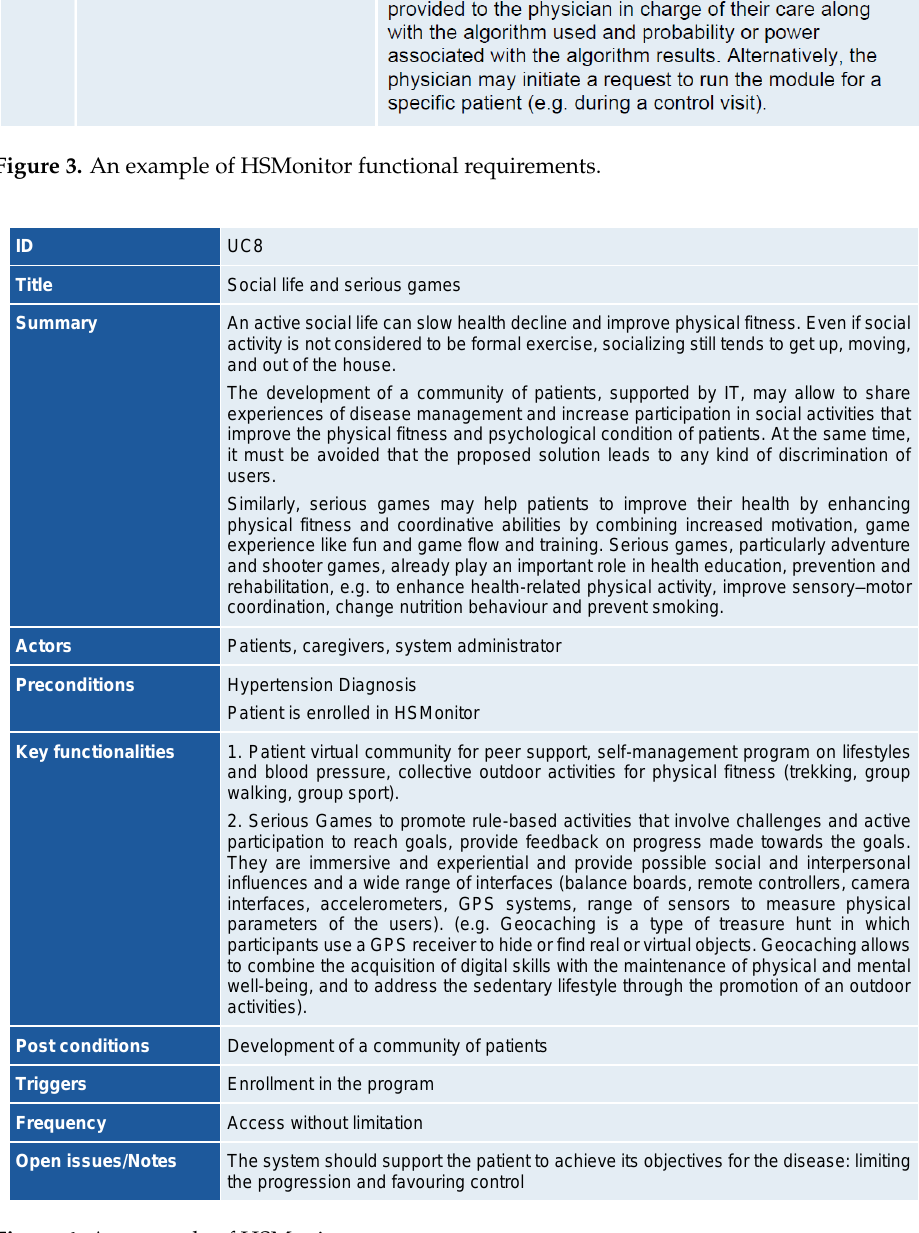
Figure 4. An example of HSMonitor use